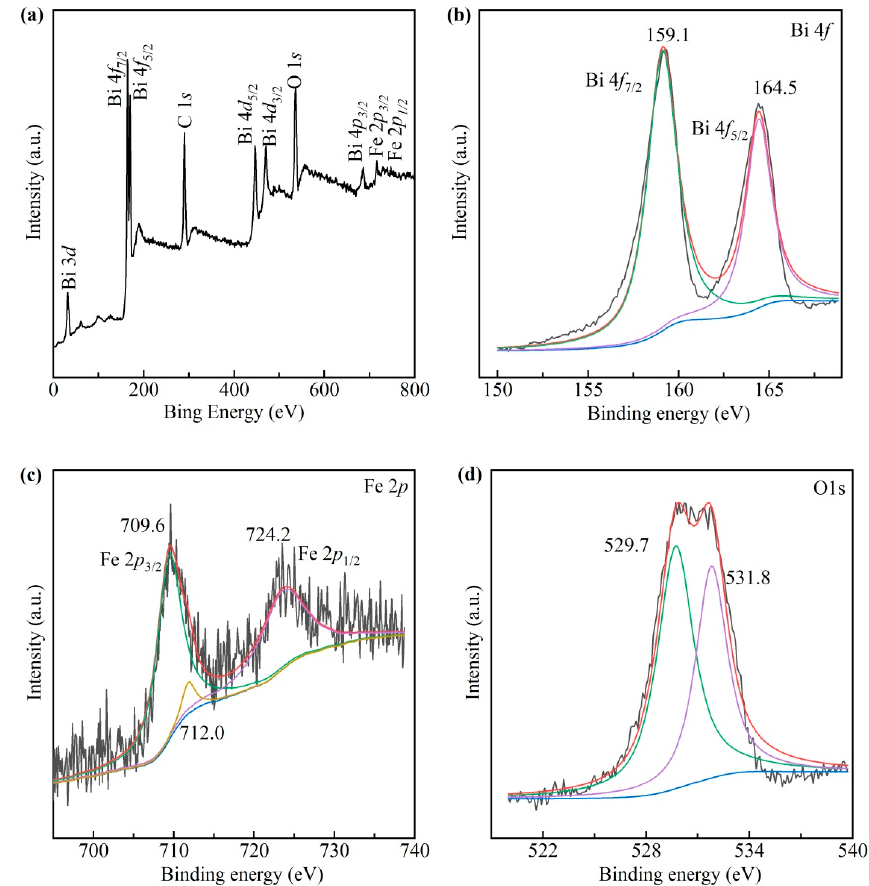
Figure 4. XPS survey spectra of BiFeO 3 nanocrystals sintered at 500 °C: ( a ) Full XPS, ( b ) Bi 4f, ( c ) Fe 2p, and ( d ) O 1 s.